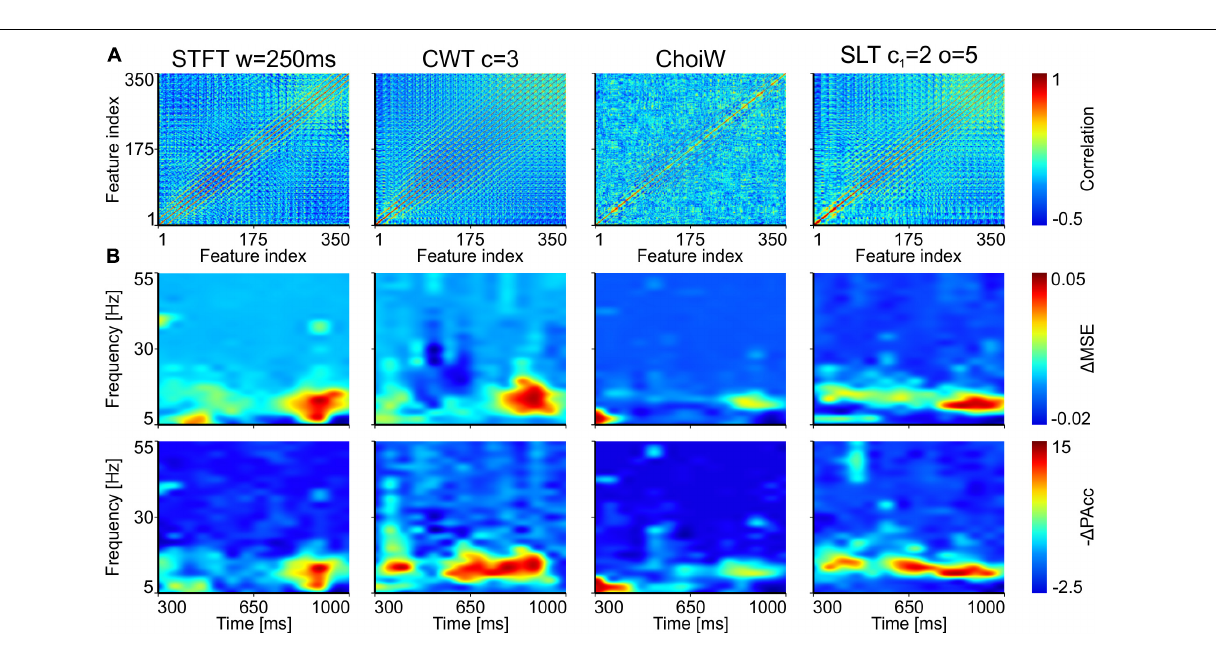
FIGURE 6 | Importance of time-frequency components for distinguishing experimental conditions in the EEG data. (A) Pairwise feature correlation for each method. (B) Top row: increase in MSE ( (cid:49) MSE) when features (time-frequency components) are randomly permuted between trials. Bottom row: magnitude of decrease of prediction accuracy (- (cid:49) PAcc) as a result of feature permutation. Larger positive values represent more important features for correct